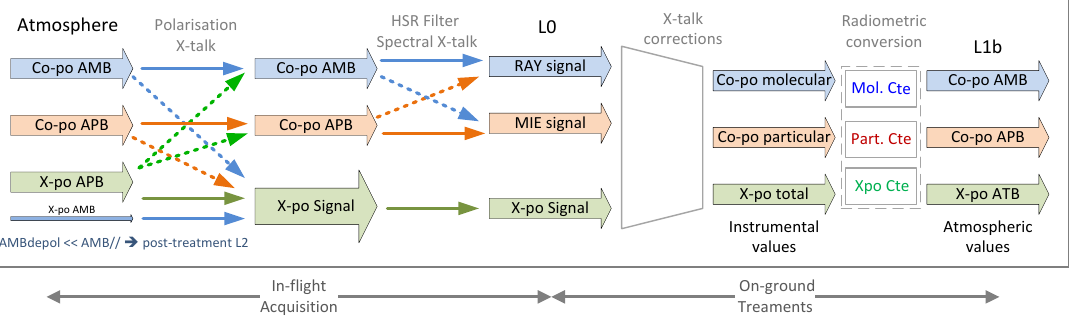
Figure 14. Illustration of signal cross talks and need for cross talk corrections.